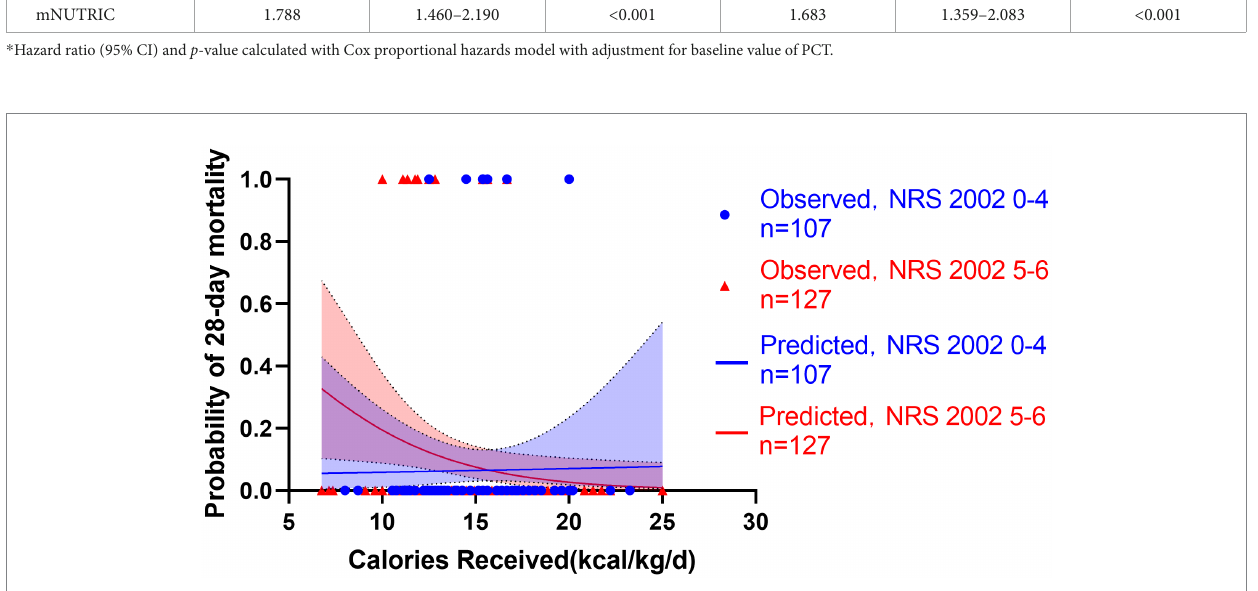
FIGURE 6 Predicted probability of 28-day mortality versus calories received by low NRS 2002 0-4 (blue line, n = 107) versus high NRS 2002 5-6 (red line, n = 127). Blue cycles represent the low NRS 2002 cases while red triangles represent the high NRS 2002 cases. Test for interactions were assessed by a logistic model including the NRS 2002, the energy provision and their product (interaction). The NRS 2002 was found unable to modify the relationship between energy provision during first week and 28-day mortality ( p =